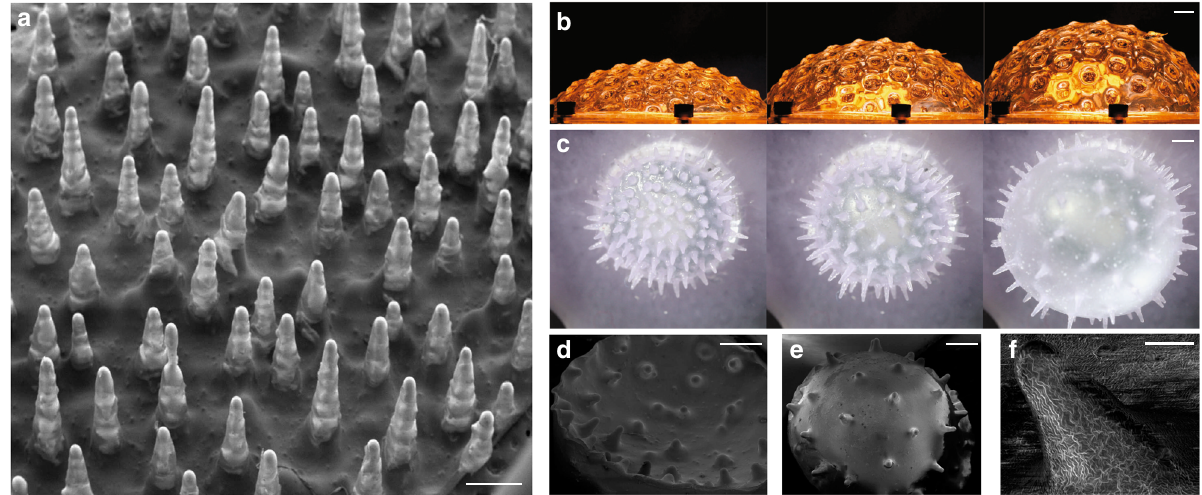
Fig. 5 Complex elastic surfaces. a Hairy elastic surfaces obtained repeating our methodology 16 times with an acceleration fi eld R Ω 2 / g = 404. Scale bar, 500 μ m. b A hexagonal lattice of drops ( R Ω 2 / g = 1) is pneumatically in fl ated to form a dimpled sphere. Scale bar, 10 mm. c Similar deformable structures are formed and actuated at the microscale ( R Ω 2 / g = 404). Scale bar, 1 mm. d – f SEM images of structures ( R Ω 2 / g = 632) permanently deformed on negative ( d , scale bar, 500 μ m) and positive ( e , scale bar, 500 μ m) Gaussian curvature and additional wrinkle morphology ( f , scale bar, 20 μ m) observed with an acceleration fi eld R Ω 2 / g = 1.2 × 10